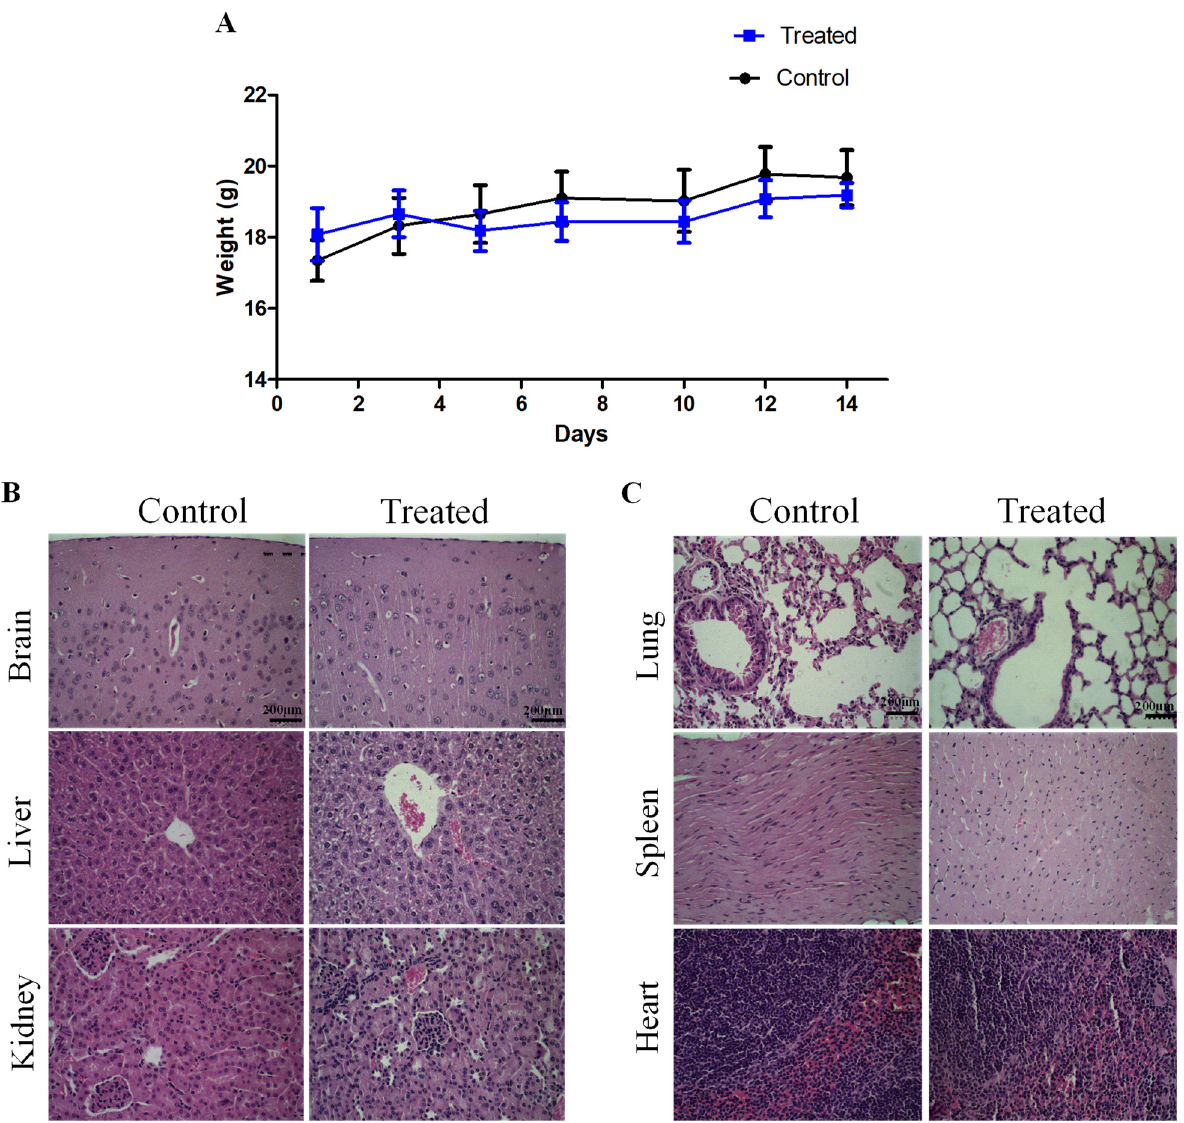
Figure 3. In vivo sub-acute toxicity after i.p. injection of LyeTxI-b peptide (5 mg/kg) ( A ) Effect of the peptide (5 mg/kg) on body weight of BALB/c mice over 14 days, n = 6. ( B ) Murine histopathological analyses of brain, liver, and kidney ( C ) Murine histopathological analyses of lung, spleen and heart. All tissues were stained with hematoxylin and eosin. Objective, 40×. Scale bar, 200 µm.